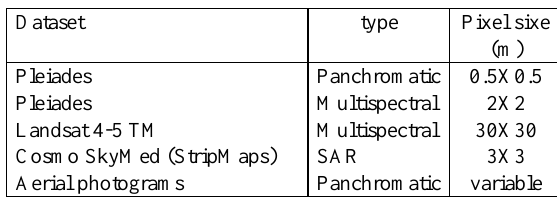
Table 1. Details of the datasets